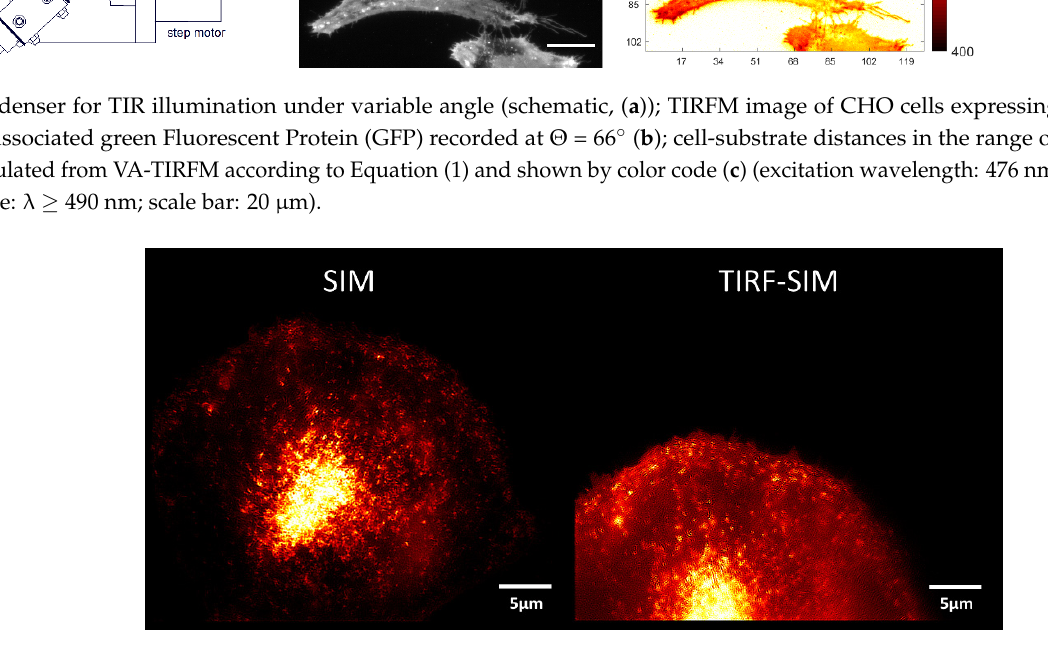
Figure 3. Comparison of SIM ( left ) and SIM-TIRFM ( right ): CHO-K1-hIR-myc-GLUT4-GFP cell, excitation wavelength: λ ex = 488 nm; detection range: λ D ≥ 515 nm; Plan Neofluar 40×/1.30 oil immersion lens ( left ) or Plan Apochromat 63×/1.46 oil immersion objective lens ( right ). GFP fluorescence arising from intracellular vesicles ( left ) or the whole plasma membrane ( right ). Reproduced from [15] with modifications.